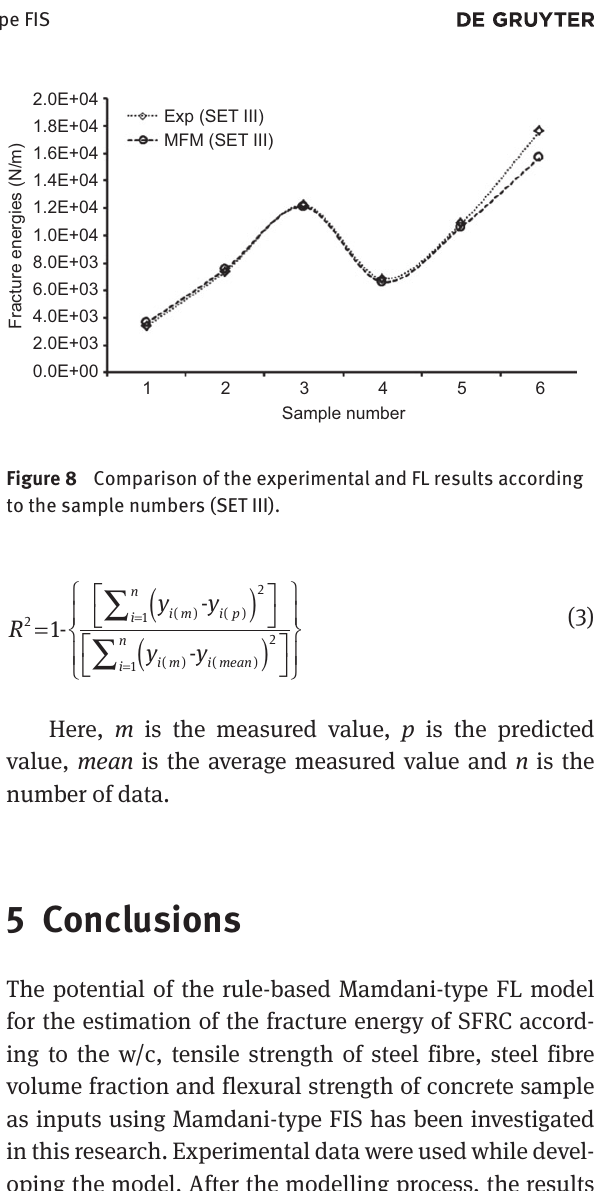
Figure 7 Comparison of the experimental and FL results according to the sample numbers (SET II).